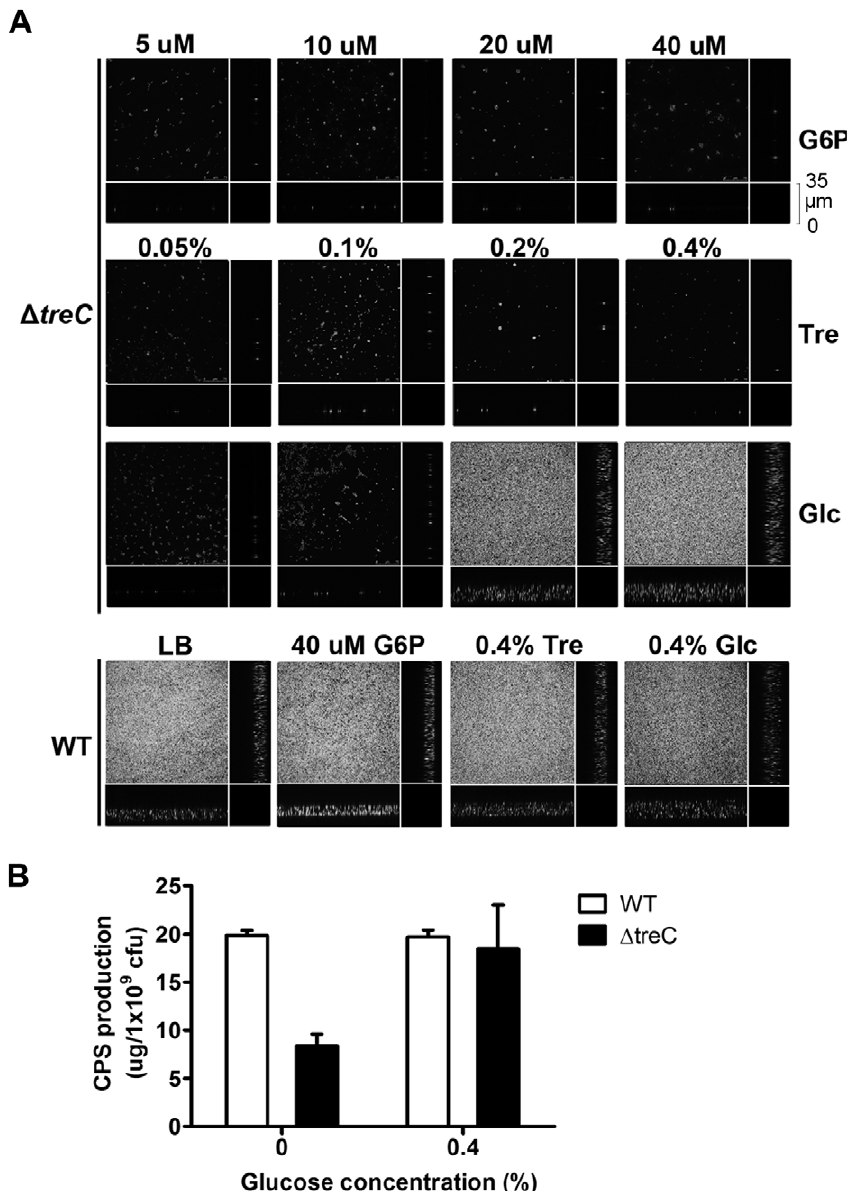
Figure 7. Biofilm and capsular polysaccharide production of D treC in Luria-Bertani broth supplemented with glucose. A, Biofilm formation by K. pneumoniae NTUH-K2044 and D treC on glass surface. GFP-expressing K. pneumoniae strain was grown on glass cover slide and harvest at 16 h. The cover slides were washed with PBS twice while shaking. The fluorescent signals were observed with a confocal microscope using oil immersion under 400 6 . The 177 sections obtained at 0.2 m m intervals were processed using Bitplane Imaris. Data represent one of two independent experiments. B, The capsular polysaccharide of wild-type strain (WT) and D treC grown in Luria-Bertani (LB) broth, or LB broth supplemented with 0.4% of glucose were extracted and determined by sulfuric acid assay. *, p , 0.05. Data shown are mean from three independent experiments. doi:10.1371/journal.pone.0023500.g007 manB displayed higher expression levels in the D sugE mutant compared to those of the wild-type strain (Fig. 8). Moreover, rmpA , a gene encoding a known regulator of the capsular gene cluster, also was induced in D sugE . The expression of two housekeeping genes, rpoB and gyrA , did not differ significantly between the wild-type strain and D sugE , providing an internal control. These results suggested that the increase of CPS production in D sugE may reflect elevated cps gene expression (upregulated through rmpA ) in combination with increased treC expression.